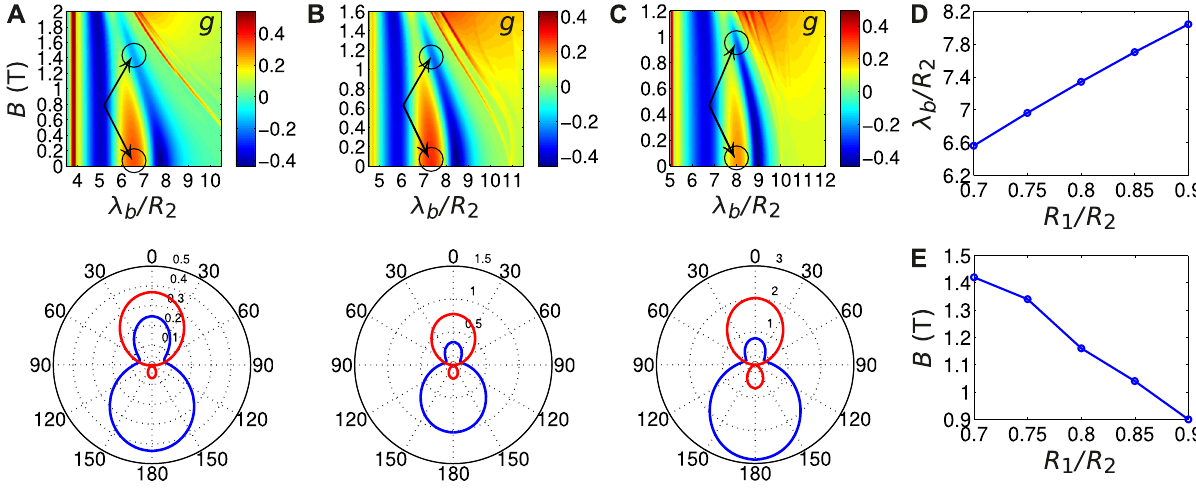
Figure3: Scattering-assymetrymapsandpolar/bistaticscatteringcrosssections(far-fieldplots)formultiplesetupswithvarious R 1 / R 2 ,when R 2 is fi xed at 10 μ m. (A) R 1 / R 2 (cid:2) 0 . 7. Top: map of g . Bottom: σ / ( π R 2 2 ) at λ b / R 2 (cid:2) 6 . 56. Red: forward-scattering at 0 T; blue: back-scattering at 1.42 T. (B) R 1 / R 2 (cid:2) 0 . 8. Top: map of g . Bottom: σ / ( π R 2 (C) R 1 / R 2 (cid:2) 0 . 9. Top: map of g . Bottom: σ / ( π R 2 wavelength versus R 1 / R 2 for which the setup supports active directionality inversion. (E) Values of B versus R 1 / R 2 for achieving preferential